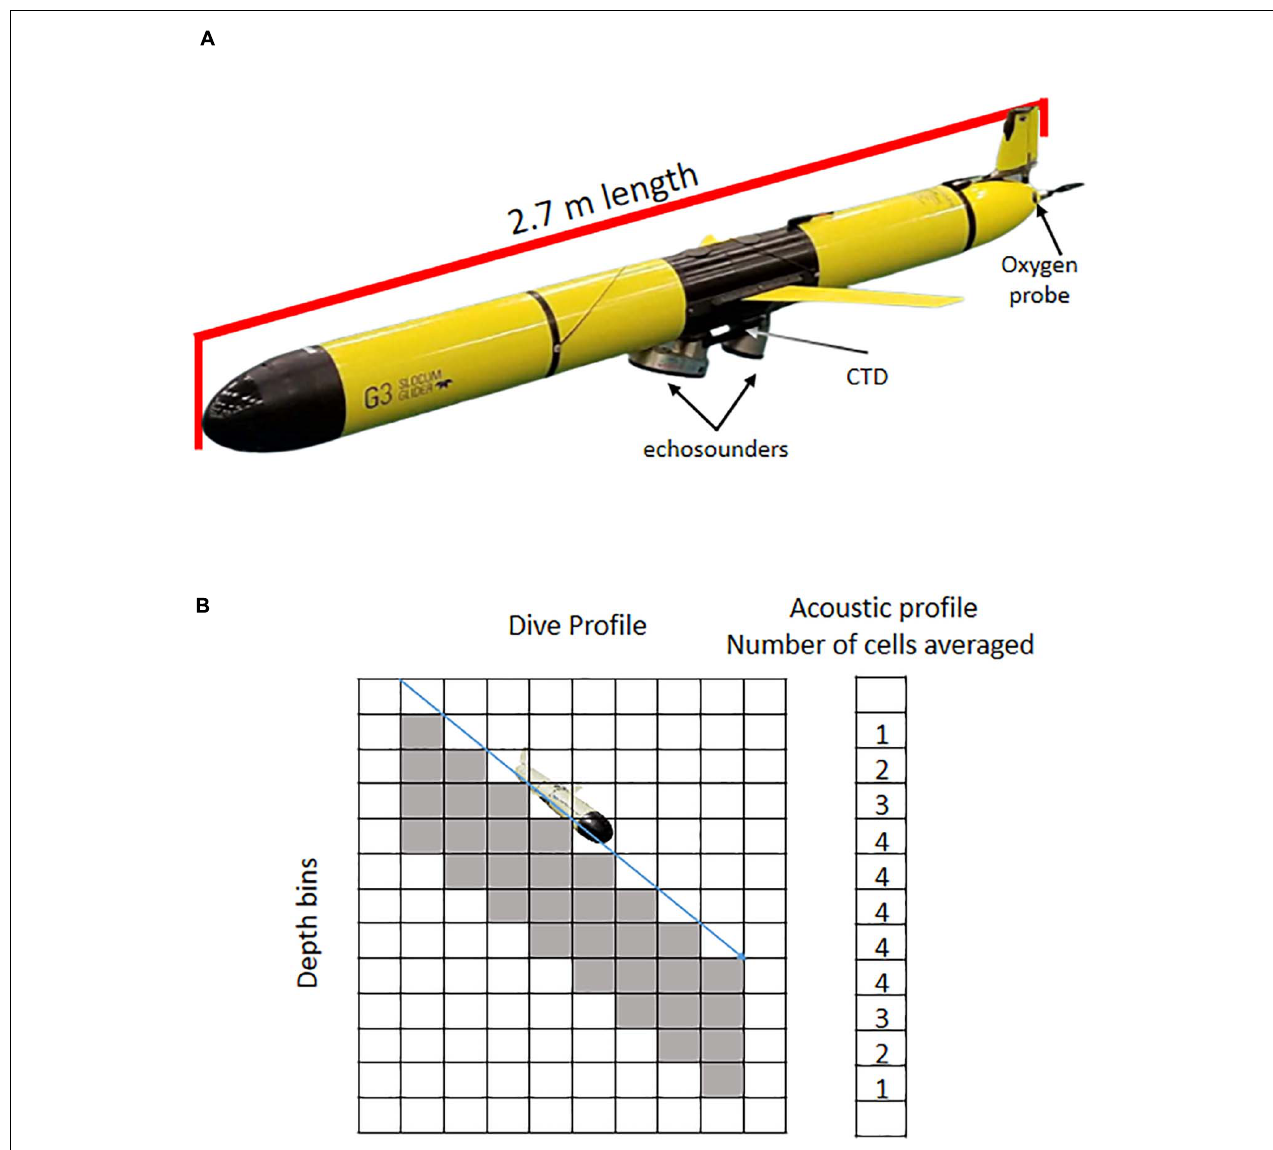
FIGURE 2 | (A) Standard glider configuration illustrating the size and payload of U.S. AMLR gliders. The three frequency Acoustic Zooplankton and Fish Profiler (AZFP) is mounted in an extended science bay, with Seabird CTD visible above it and the oxygen probe near the propeller. (B) Diagram illustrating the process for converting acoustic observations collected during a glider dive into an acoustic profile. Acoustic observations are collected from a fixed range below the glider and along its glide path. Processed acoustic data (1 × 1 m bins) are averaged at each depth to convert the dive profile into a vertical